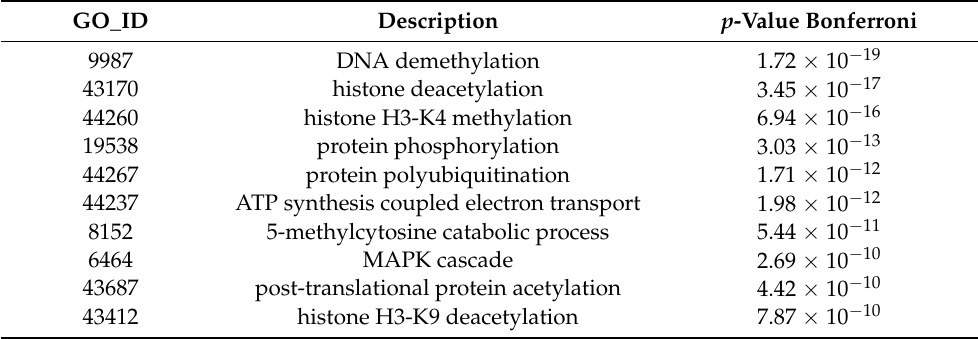
Table 3. Top ten GO categories—biological processes involving the over-expressed genes in Down syndrome brain